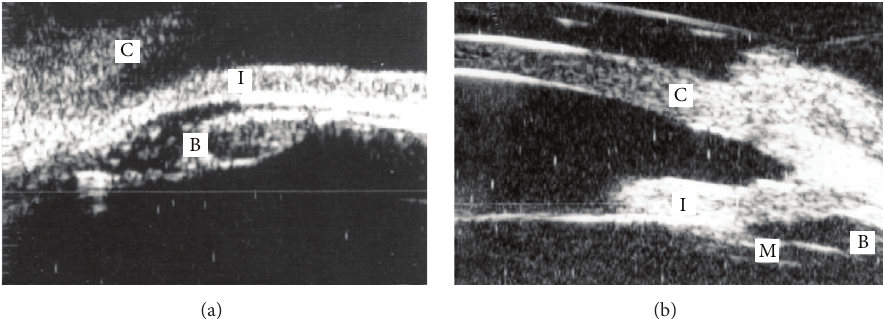
Figure 1: Ultrasound biomicroscopy (UBM) of malignant glaucoma. (a) The patient with a history of angle closure glaucoma and a patent laser iridotomy presented after glaucoma filtration surgery with elevated intraocular pressure. UBM showed shallow anterior chamber and anterior rotation of the ciliary body. (b) After treatment with cycloplegic medication and topical steroids, the anterior chamber deepened and the ciliary body returned to normal position. C, cornea; I, iris; B, ciliary body; and M, hyaloid membrane (reprinted by permission from